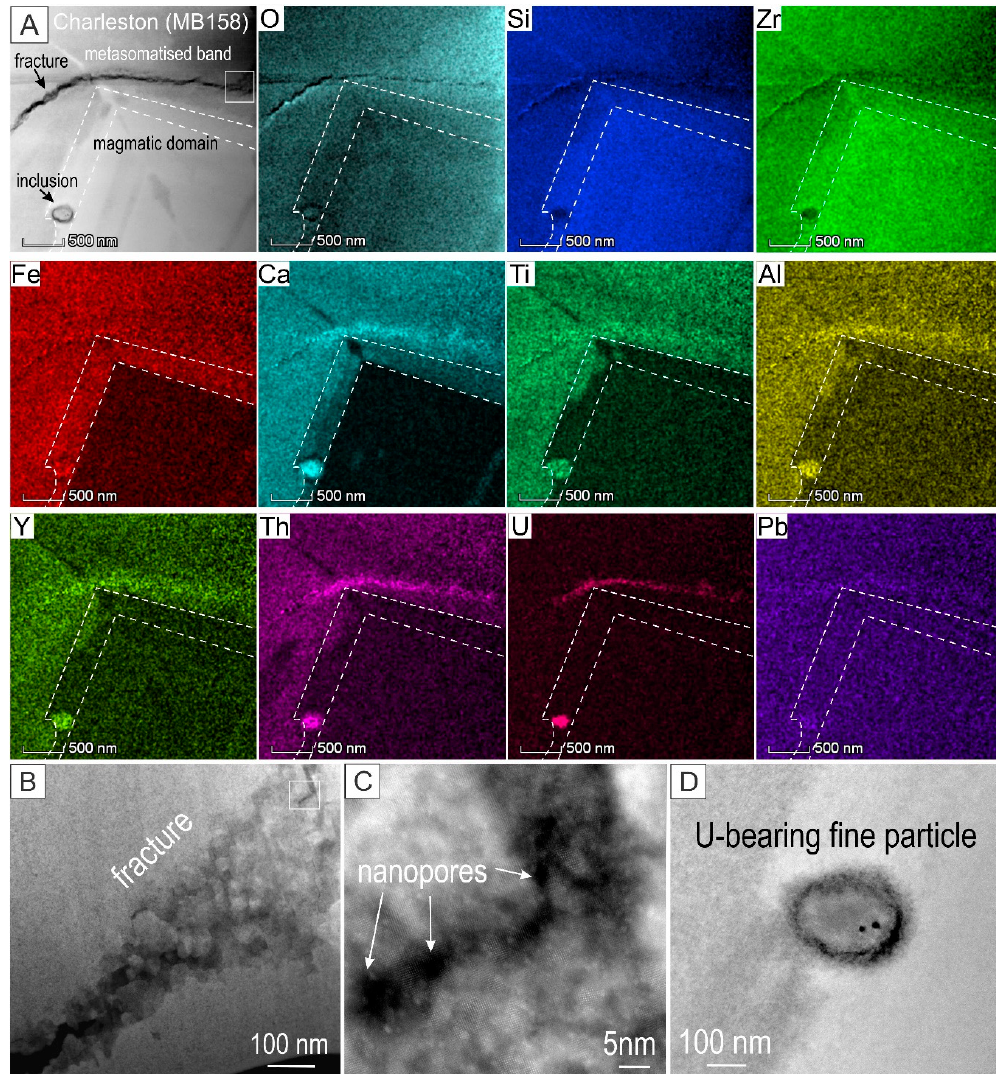
Figure 7. ( A ) HAADF STEM image and EDS STEM element maps of Charleston zircon (Foil #6) showing enrichment in trace elements outside of a magmatic domain as marked. Note the sharp boundary (dashed lines) for Fe but not the other elements, which instead display a diffuse boundary. Trace element (re)mobilization (all elements except Fe) along this boundary was observed along the adjacent fracture and the U-bearing fine particle. ( B – D ) HAADF STEM images showing zircon details along the fracture as marked. The U-bearing fine particle ( D ) displayed a dark rim and was beam-sensitive, indicating that it was most likely amorphous (it could not be imaged at high-resolution due to the thickness of the foil at this location). The image in ( B ) is the inset box indicated on ( A ), and image ( C ) shows the inset box indicated on ( B ). Image ( D ) shows detail of the inclusion from image (A).